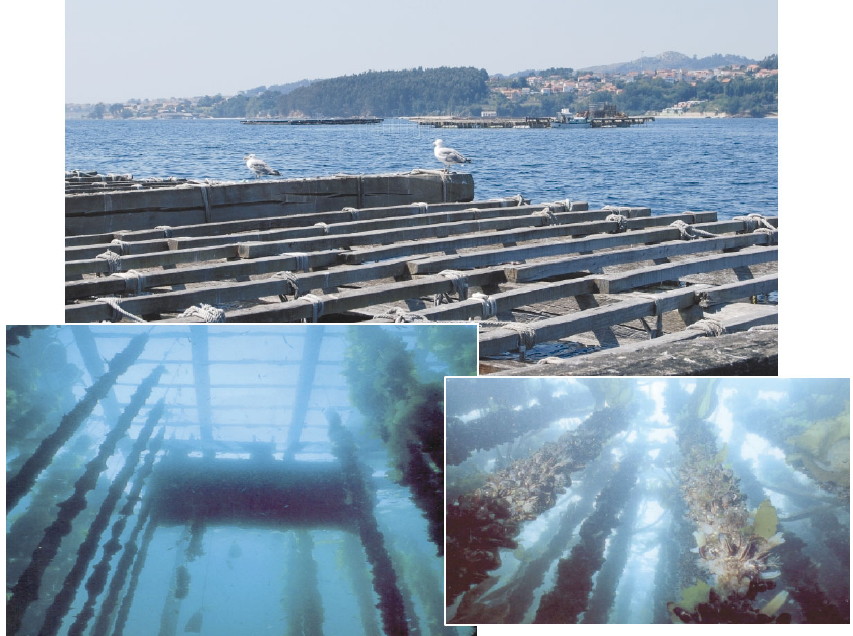
Fig. 1. Wooden floating rafts in the mussel farms from the Ría of Vigo. (Images from Durán Neira et al.